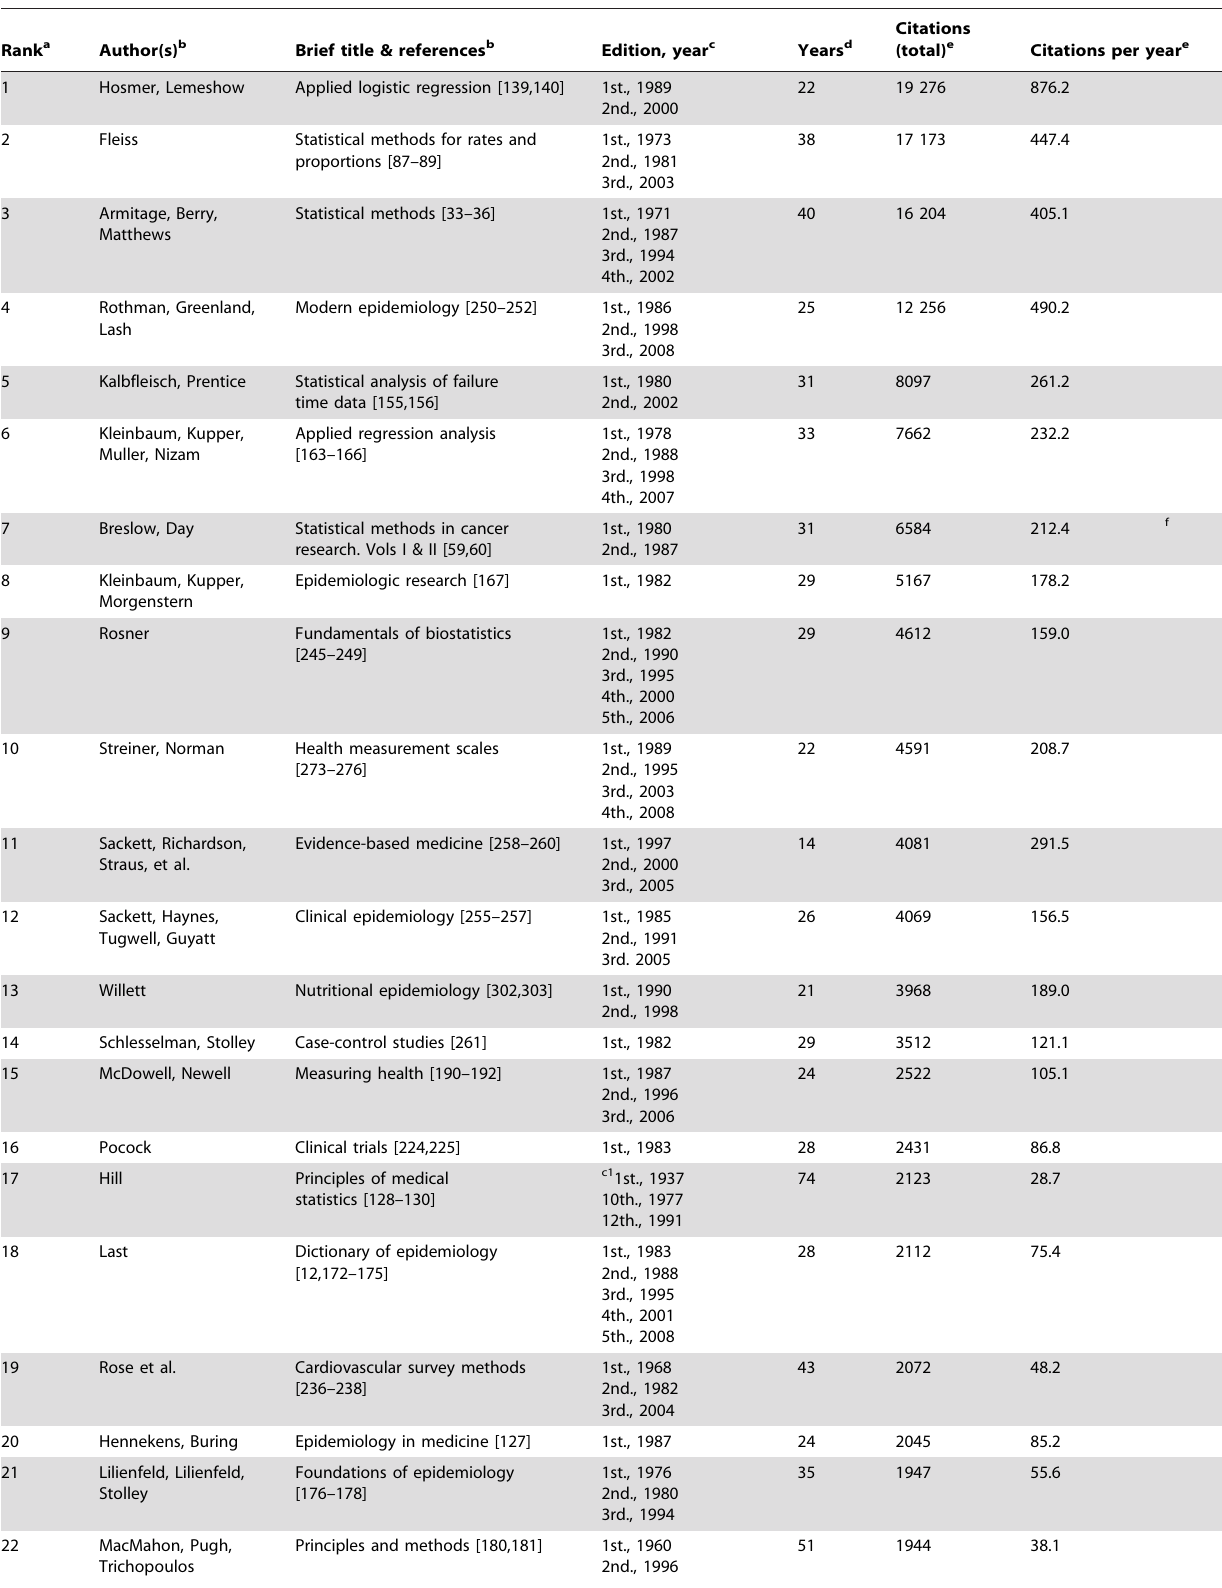
Table 2. Number of citations received by books on epidemiology, biostatistics and related fields.*